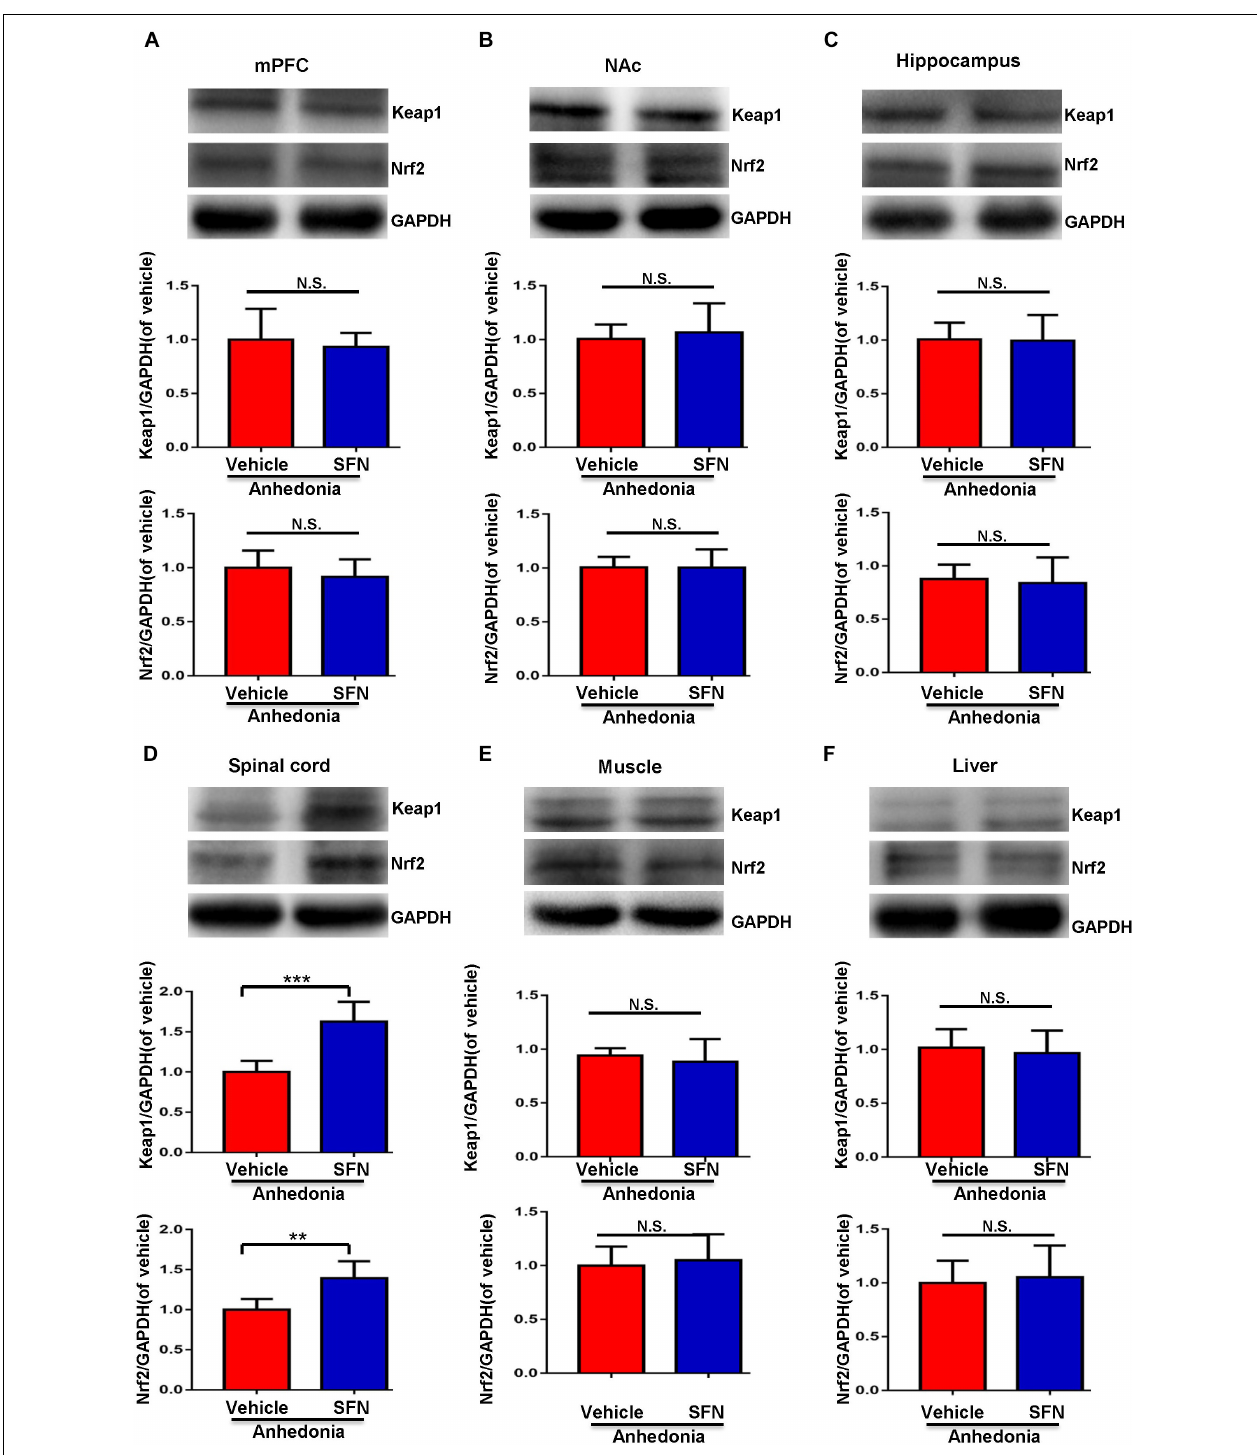
FIGURE 4 | Effects of SFN treatment after SNI surgery on the expression of Keap1 and Nrf2 proteins in selected tissues. (A) Keap1 ( t = 0.5248 , P = 0.6112) and Nrf2 ( t = 0.9042 , P = 0.3872) levels in the mPFC. (B) Keap1 ( t = 0.4853 , P = 0.6379) and Nrf2 ( t = 0.01363 , P = 0.9894) levels in the NAc. (C) Keap1 ( t = 0.1111 , P = 0.9137) and Nrf2 ( t = 0.3427 , P = 0.7389) levels in the hippocampus. (D) Keap1 ( t = 5.45 , P < 0.001) and Nrf2 ( t = 3.861 , P = 0.0032) levels in the L2-5 spinal cord. (E) Keap1 ( t = 0.6394 , P = 0.5369) and Nrf2 ( t = 0.4178 , P = 0.6850) levels in the muscle. (F) Keap1 ( t = 0.463 , P = 0.6533) and Nrf2 ( t = 0.3559 , P = 0.7293) levels in the liver. Data are shown as mean ± SEM ( n = 6). ∗∗ P < 0.01 or ∗∗∗ P < 0.001. Keap1, kelch-like ECH-associated protein 1; mPFC, medial prefrontal cortex; NAc, nucleus accumbens; Nrf2, nuclear factor (erythroid 2-derived)-like 2; N.S., not significant; SFN,